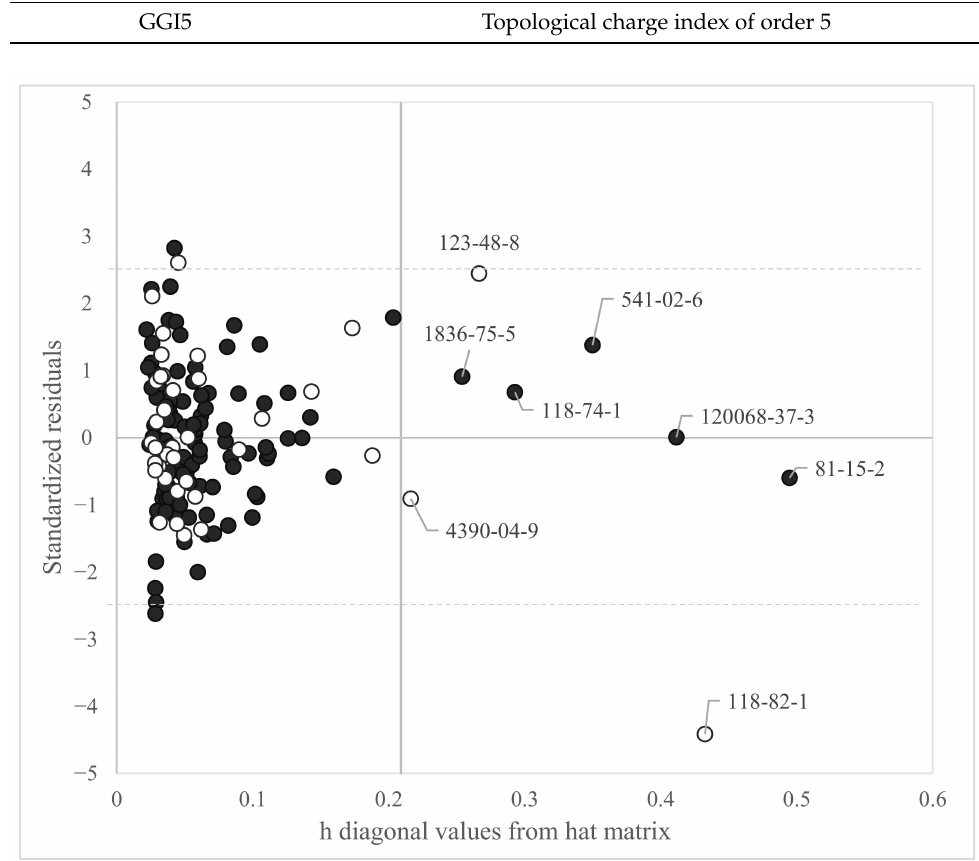
Figure 2. Applicability domain of the MLR-OLS model selected from the GA population (Equation (1)). The cut-off value on the abscissa for Equation (1) is h* = 0.209. Chemicals with h values larger than h* are outside the AD of the model. Black dots = training set. White dots = prediction set. The split model Equation (1) was recalibrated, pooling the training and the prediction set. The equation (Equation (2)) of the full model is reported